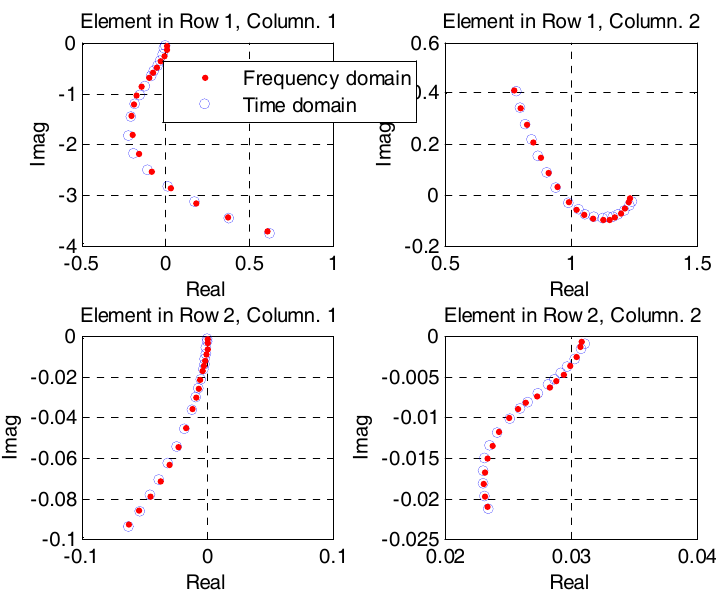
Figure 10. The aerodynamic influence coefficient (AIC) matrix obtained in the frequency domain and approximated in the time domain via the rational function approximation (RFA) and the minimal state (MS) methods. Two lag terms, − 0.08 and − 0.06, are included in the RFA.